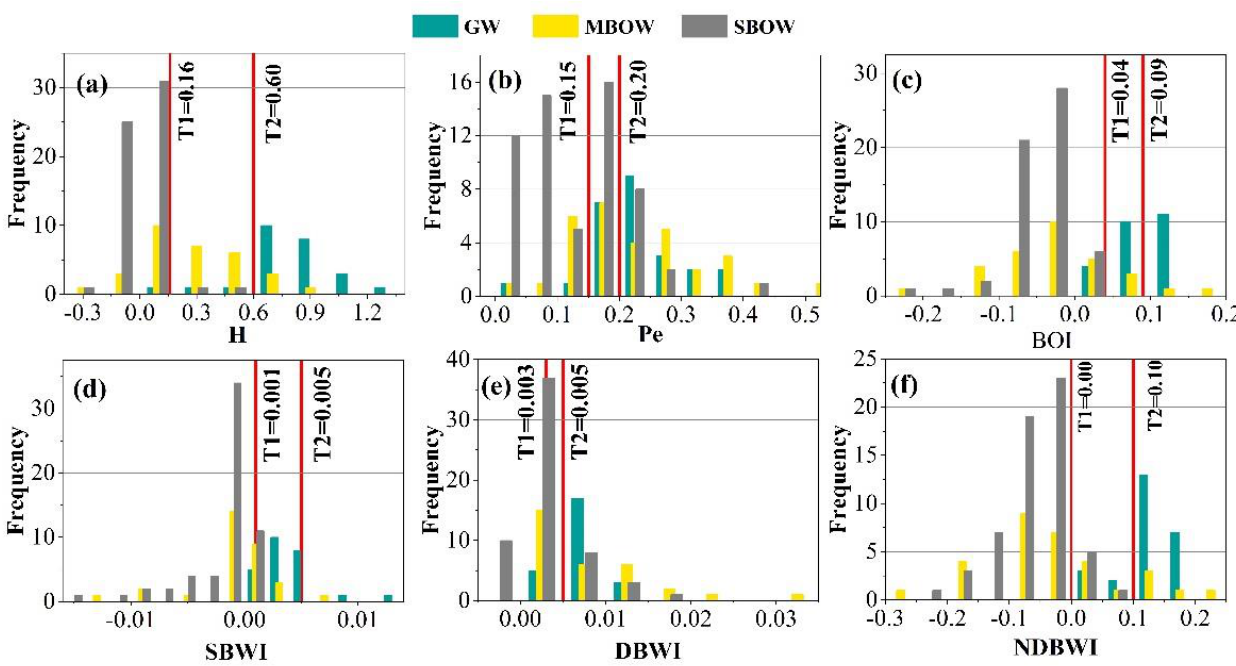
Figure 3. Model threshold determination. The two red lines show the threshold values between GW, MBOW, and SBOW. The center line of the light gray column (light BOW) was taken as the model extraction result corresponding to the horizontal axis. ( a – f ): the frequency distribution histogram of six kinds of BOW identification models: H index, Pe, BOI, SBWI, DBWI, and NDBWI, respectively.